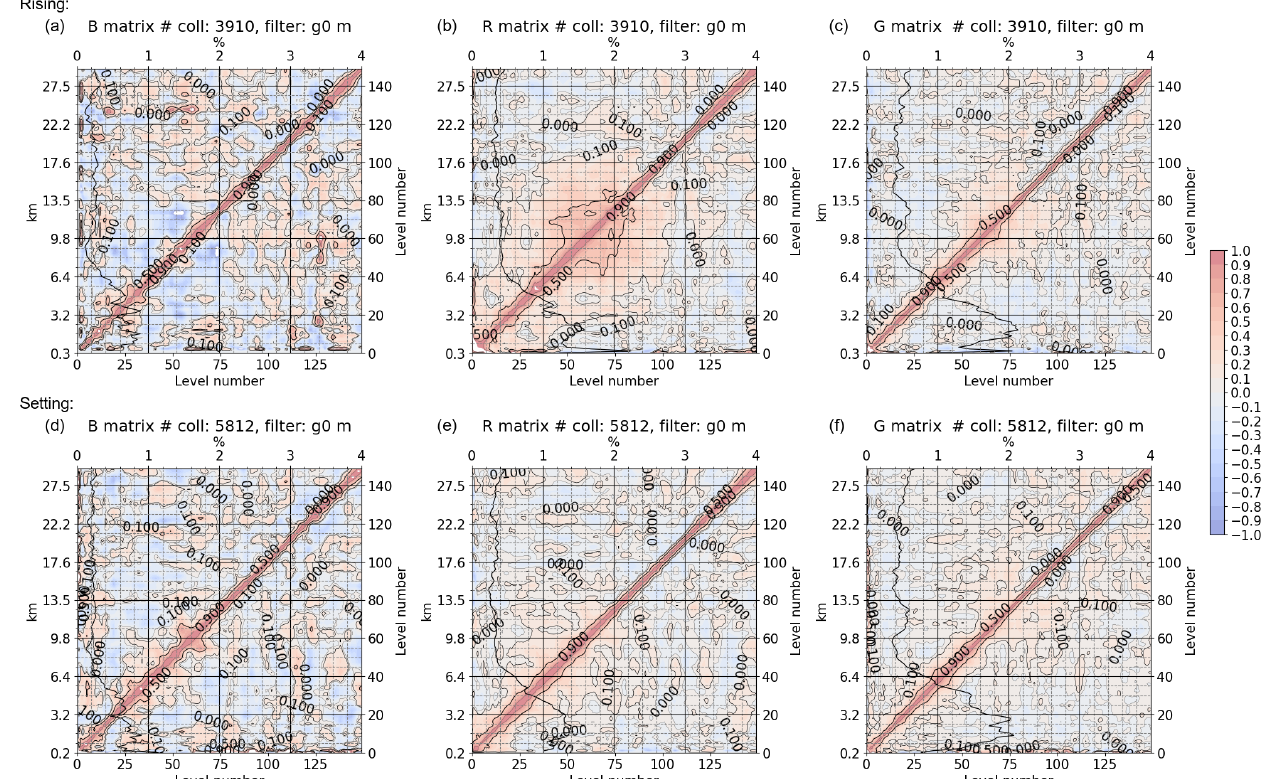
Figure 11. G3CH estimate of ERA5 (a, d) , RO (b, e) , and RS92 (c, f) refractivity vertical error covariance matrices at middle latitude. Rising occultations (a–c) and setting occultations (d–f) . The covariance matrices are plotted as correlation matrices (diagonal = 1) with superimposed standard deviation as a function of height (black line), plotted on the left and upper axes. The standard deviation is given as percent of the mean ERA5 forecast refractivity. The covariance matrices have been truncated at 30km where the RS92 data sparseness starts to destabilize the results. A total of 9722 collocated profile triplets were used for these covariance estimates. For these estimates no smoothing was applied on any of the data